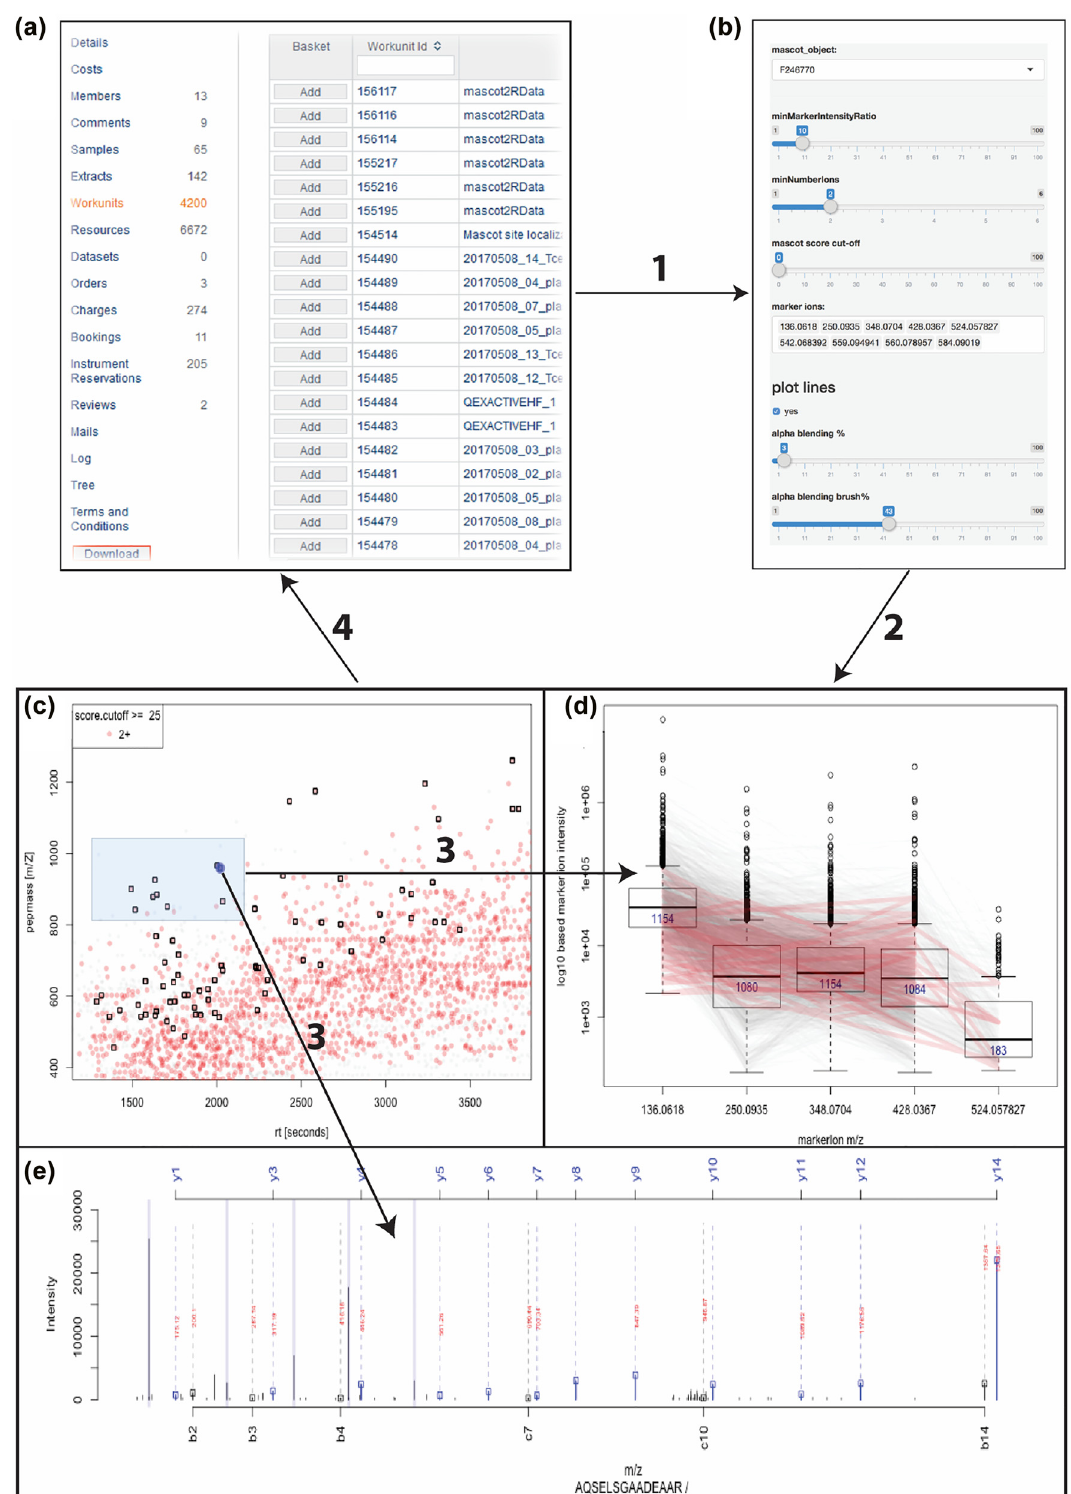
Figure 6: Example 1 – on using B-Fabric and